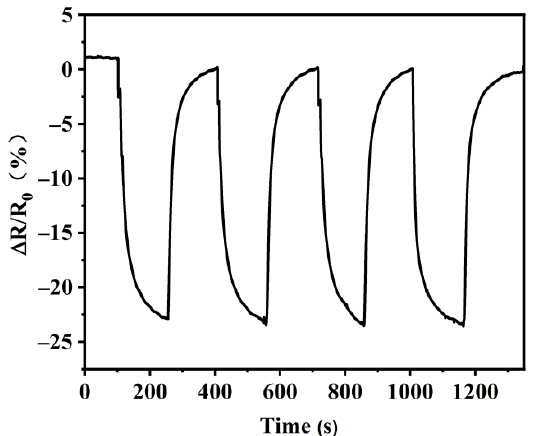
Figure 11. Reproducibility of response after exposure to 50 ppm NO 2 .